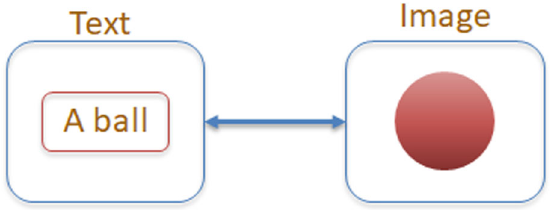
FIG. 2. A transduction is performed between the semiotic systems “ text ” and “ image.